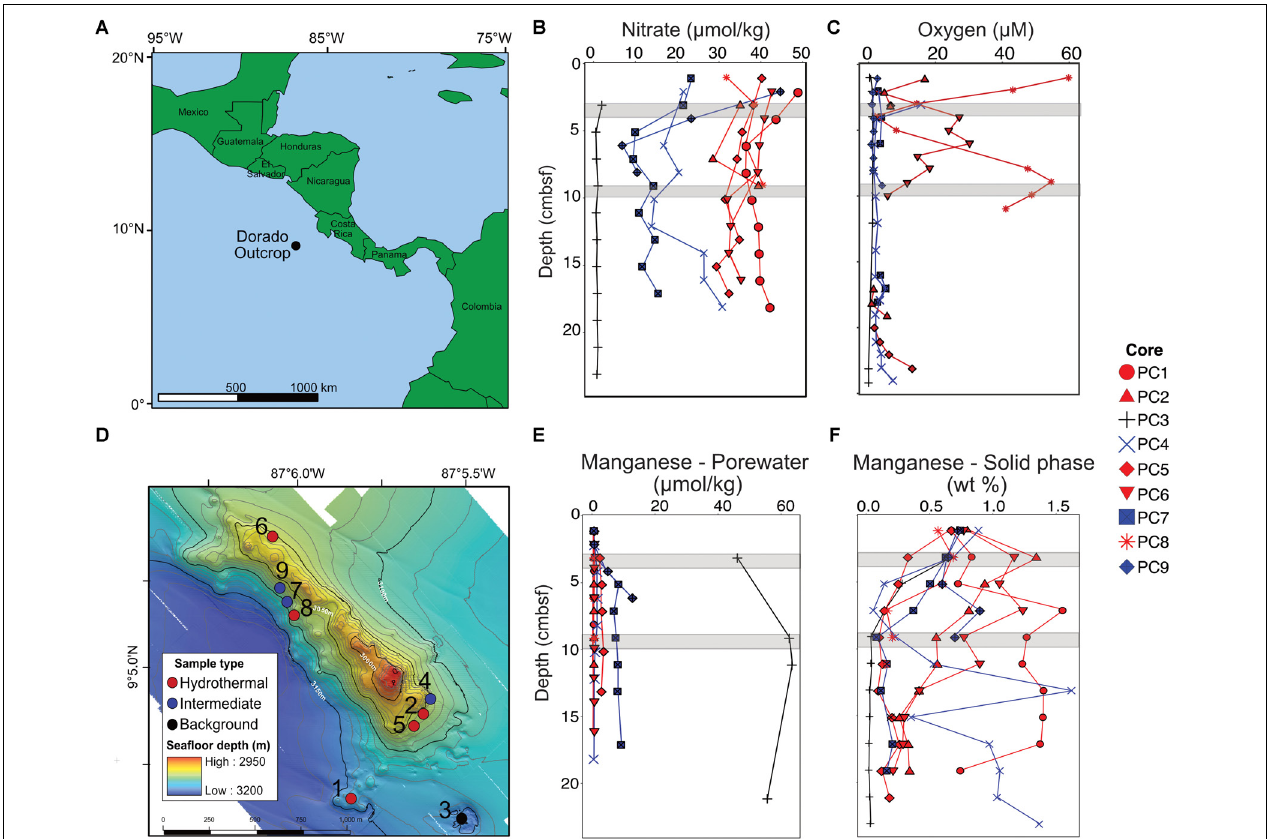
FIGURE 1 | Overview of the Dorado Outcrop (A) , locations of sediment core samples (D) , and sediment geochemical profiles (B,C,E,F) . (A) The Dorado Outcrop is located in the Eastern Tropical Pacific Ocean on a 23-million-year-old ridge flank of the East Pacific Rise. (B) Sediment profiles of pore fluid nitrate concentrations with depth (centimeters below seafloor, cmbsf). (C) Dissolved oxygen concentrations of sediment push cores from Wheat et al. (2017). (D) Bathymetric map of Dorado Outcrop, which is approximately 2 km long and 0.5 km wide, rising approximately 150 m above the surrounding thickly sedimented seafloor. Push core locations are marked by circles, with the corresponding core designation labeled next to the circles. Adapted from Wheat et al. (2017). (E) Dissolved and (F) solid phase manganese profiles from sediment push cores. In (B–F) , sediment cores were classified based on nitrate profiles, which have been shown to demonstrate advective fluid flow from the ocean basement into the thin sediments on Dorado Outcrop (Wheat and Fisher, 2008). Symbol color represents hydrothermal (red), intermediate (blue), and background sediment (black) groups. Gray areas represent where samples were collected for 16S rRNA gene